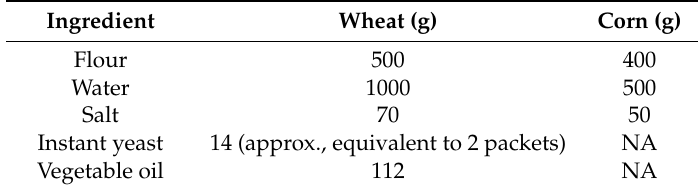
Table 2. Amount of ingredients given to dough